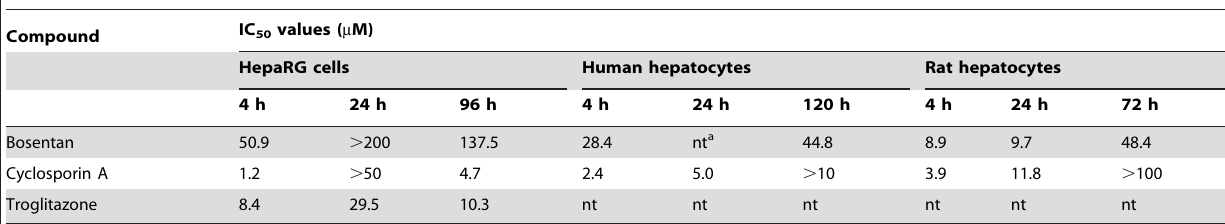
Table 1. Inhibitory potential of drugs towards TC